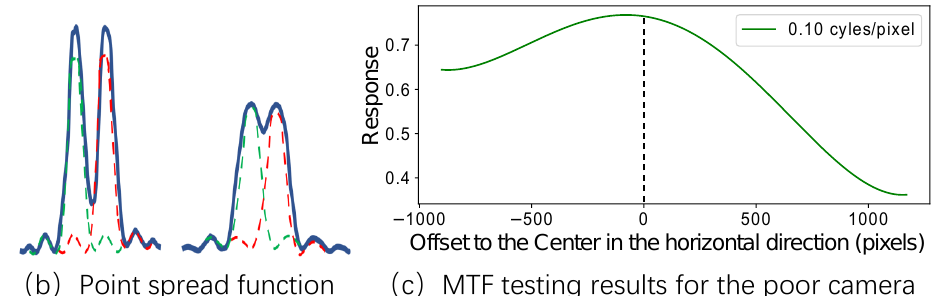
Figure 1. ( a ) shows a cropped image and the corresponding full image was captured by a camera with inconsistent imaging capabilities. ( c ) illustrates the MTF testing results for the camera. The right-hand part of the image is more blurred than the left-hand part and the control point in the yellow circle is more blurred than that in the green circle. ( b ) illustrates the two point spread functions for the two adjacent pixels at positions A and B in the top image. The blue curves in ( b ) depict the superposition of the point spread functions of the two adjacent pixels. The response in ( c ) indicates the spatial frequency response